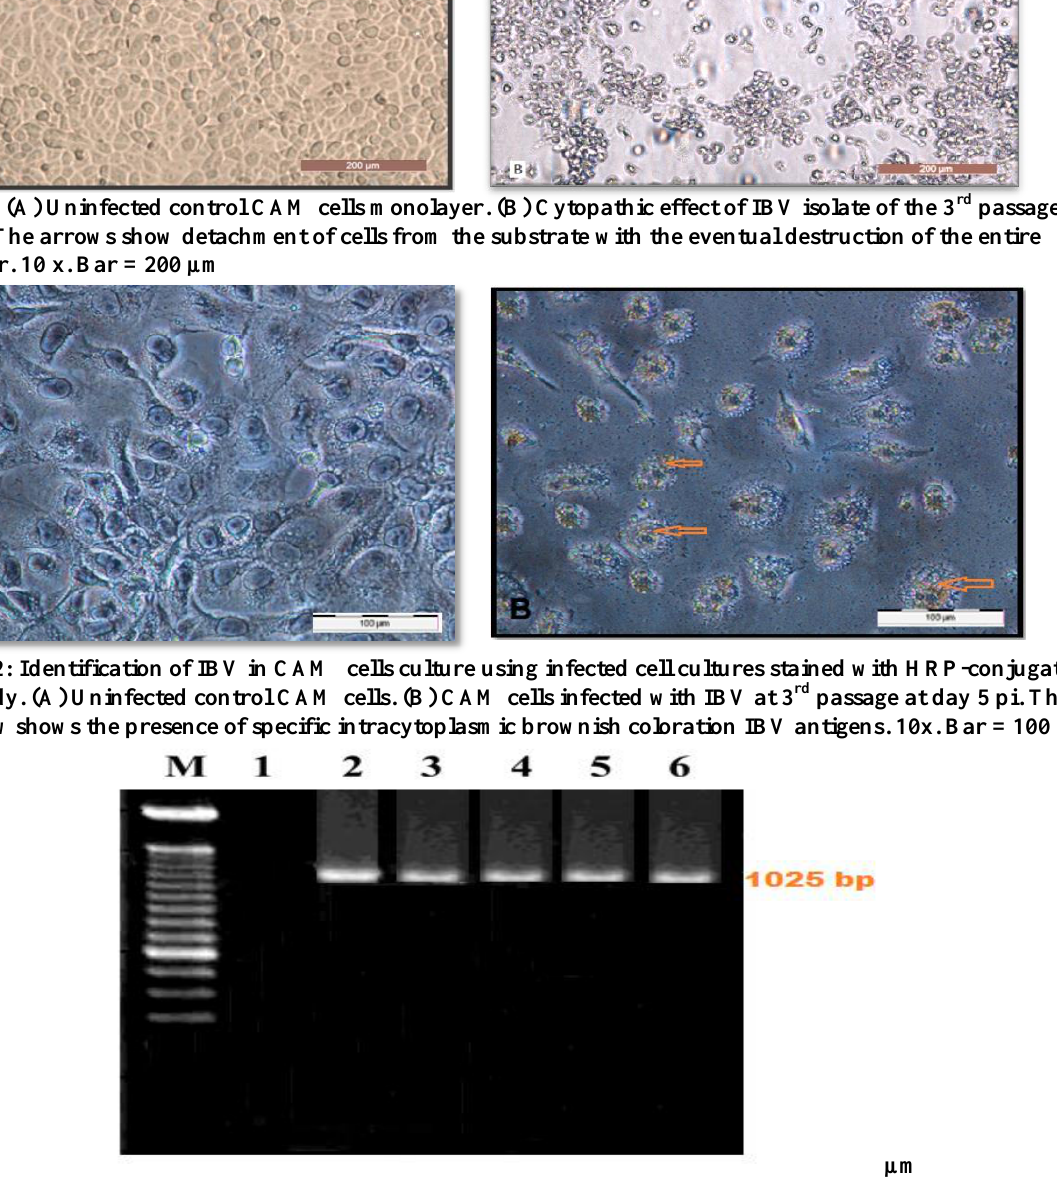
Figure, 3: S1 gene (1025 pb) of IBV. Lane 1 Negative control; Lane 2 positive passage 2; Lane 3 positive passage 5: Lane 4 passage 10; Lane 5 positive passage 15 and Lane 6 positive passage 20 ; M- 100 bp DNA marker (Promega,